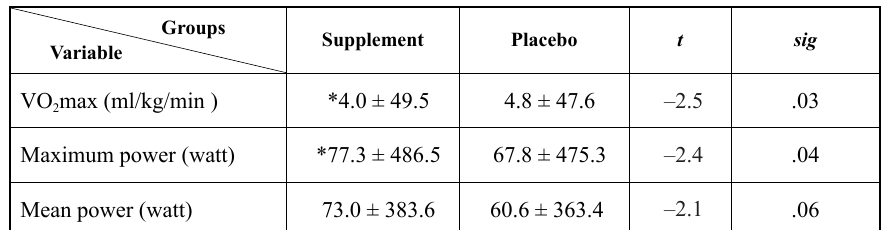
Note . * – Significant diffe-rence compared with placebo group at p ≤ .05.